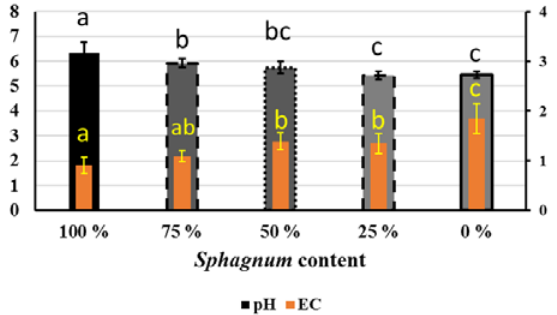
Figure 3. Average pH (left-hand axis) and electrical conductivity (EC) (mS cm − 1 ) (right-hand axis). Values obtained from pore water prior to irrigation with nutrient solution (EC 1 mS cm − 1 , pH 6.5). Letters denote the detected differences between groups (p < 0.05). Bars denote ± SD. n = 12.